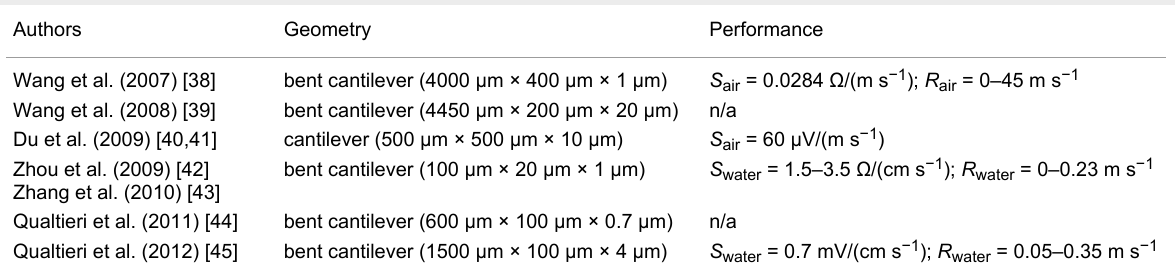
Table 1: Previously described, bent-cantilever-based flow sensors ordered by year of publication. Comparative overview of cantilever geometries and flow velocity related performance indicators (sensitivity S , measurement range R ). Hair geometry defined as product of length × width (or diameter) × thickness. Adapted from